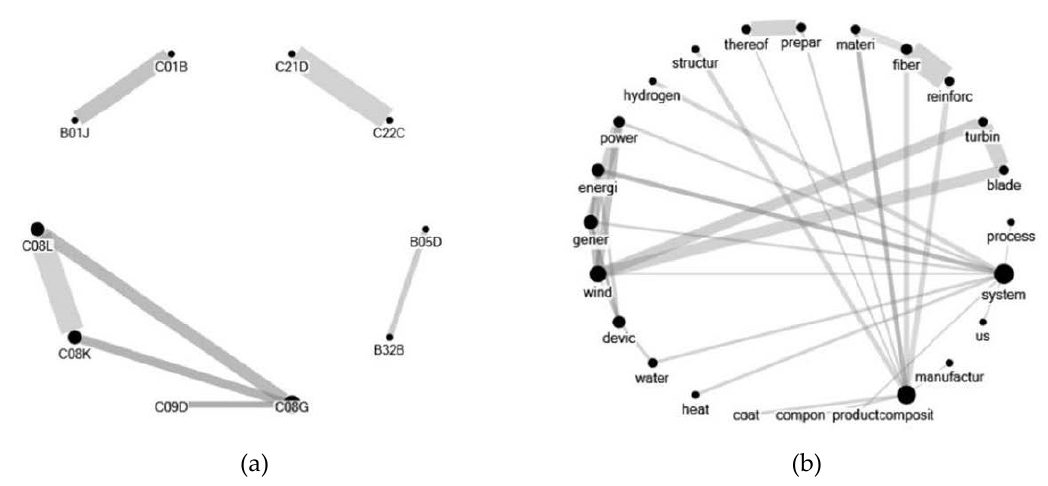
Figure 3. Chemistry network graph to visualize Association Rule Mining (ARM). (a) Chemistry IPC Network; (b) Chemistry Key Terms Network.